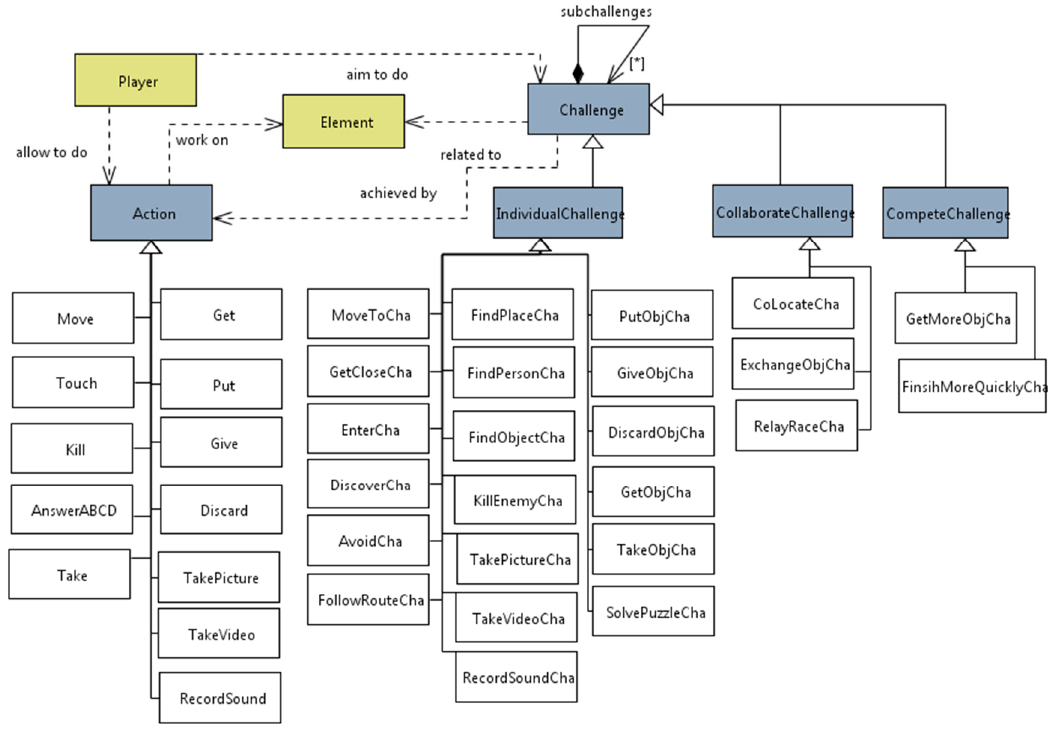
Figure 3. The pervasive game concepts in the gameplay perspective.